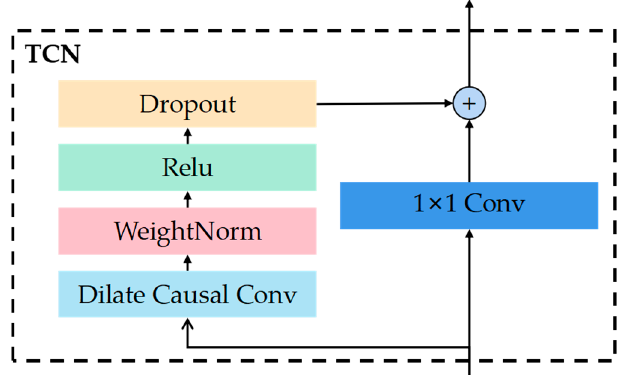
Figure 7. The structure of the TCN.